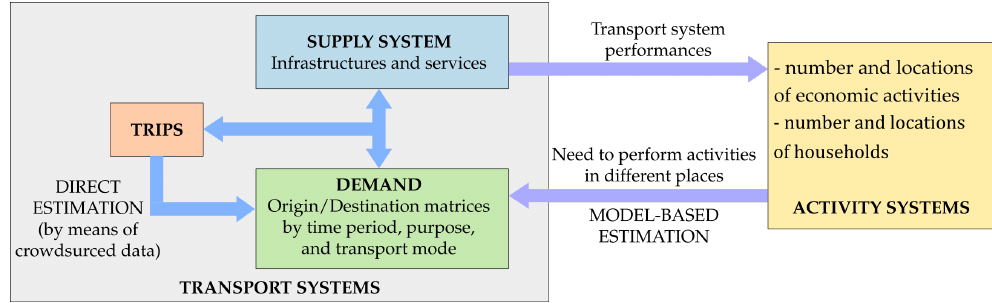
Figure 1. Relationships between the transportation system and the activity